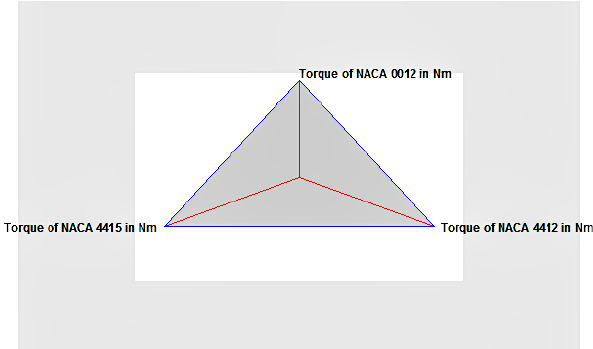
Figure 13. Torque plot for NACA 0012, NACA 4412, and NACA 4415